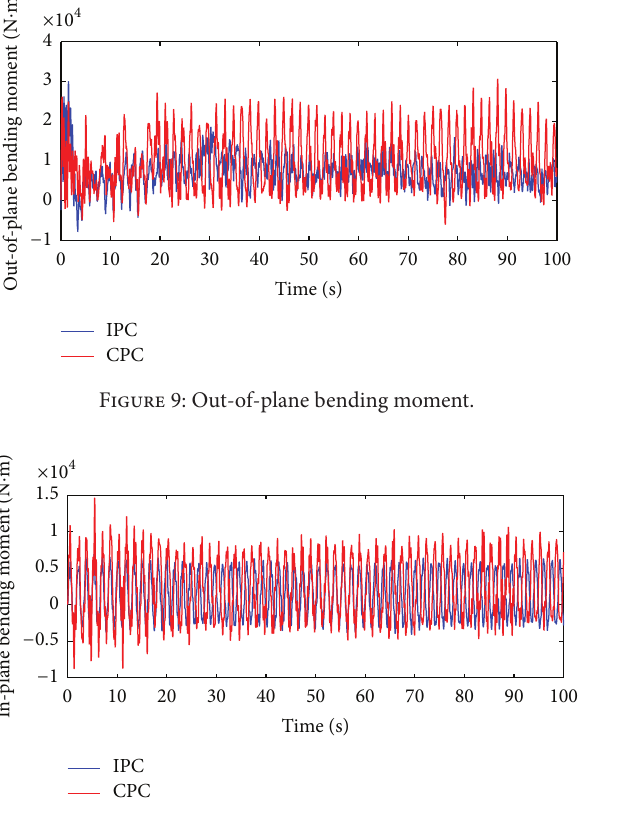
Figure 10: In-plane bending moment.